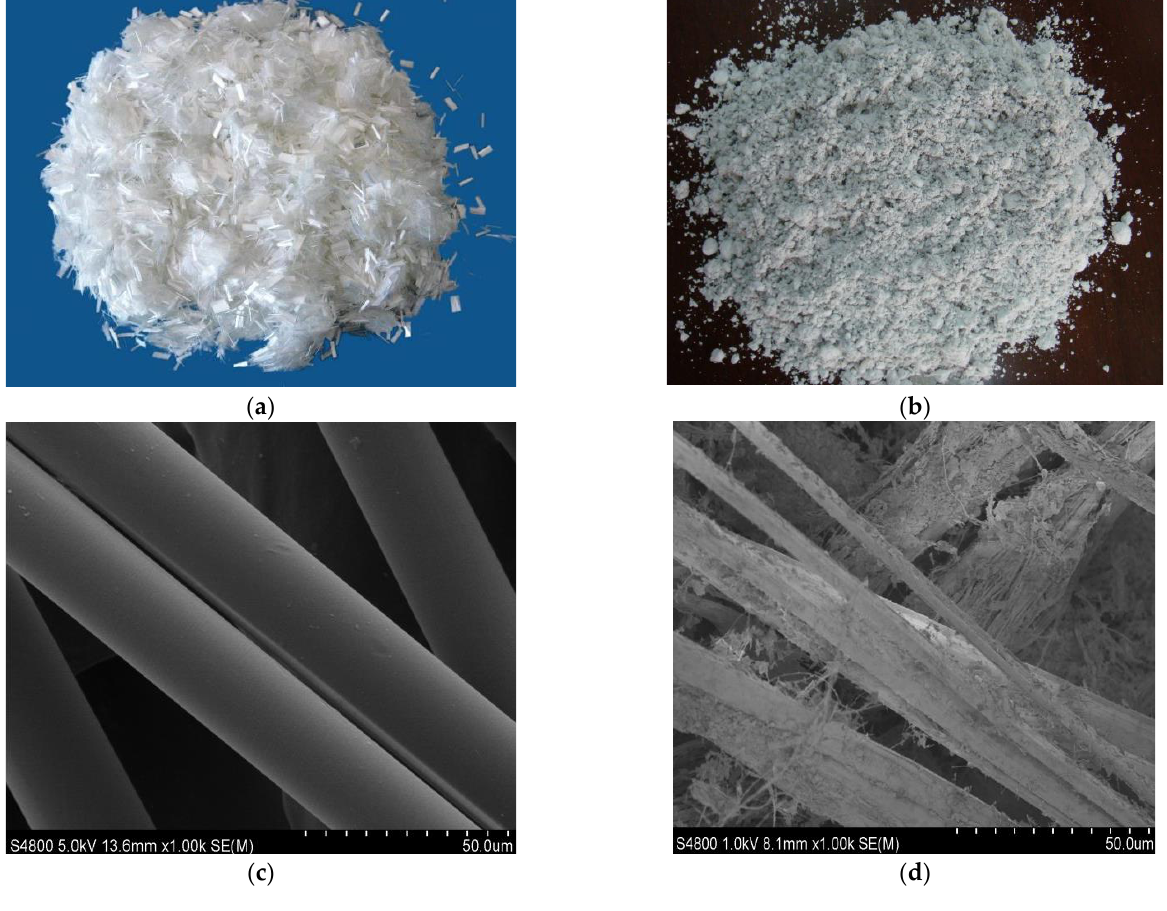
Figure 1. Photos and SEM images of ( a , c ) polyester fiber and ( b , d ) brucite